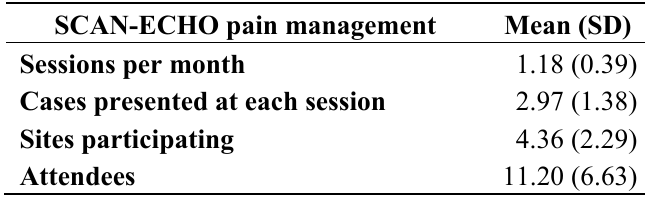
Table 1. Sessions and attendance summary for monthly Specialty Care Access Network (SCAN)-ECHO pain management session summary statistics spanning three years of service (October 2011–September